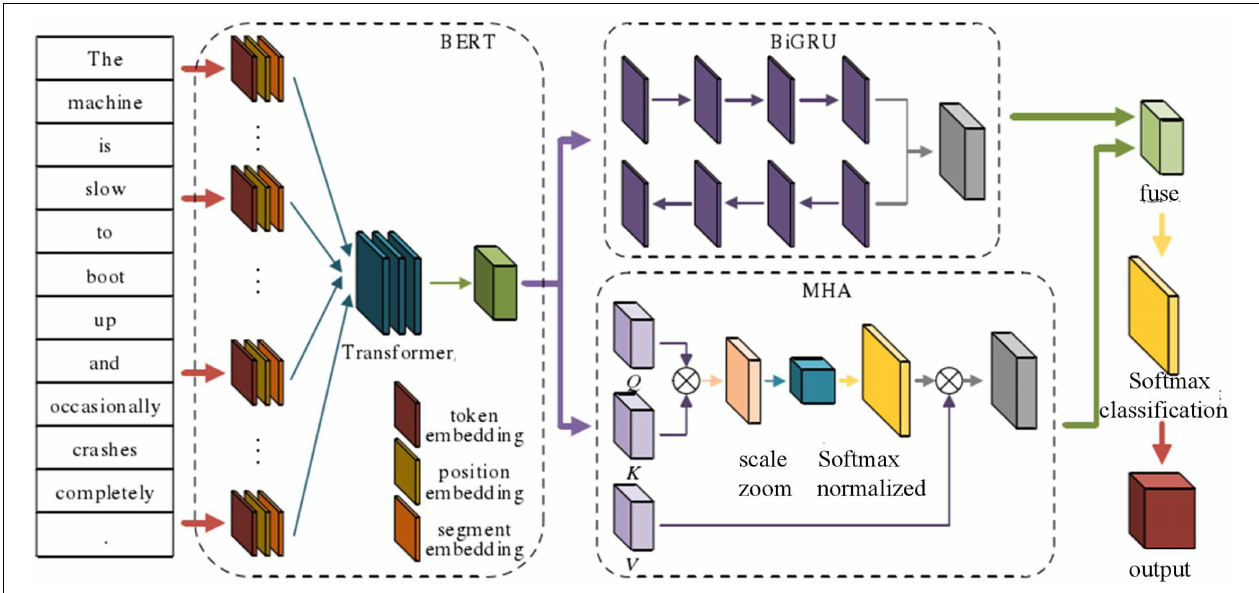
FIGURE 4 | Overall architecture of E2E-ABSA model integrating GRU and